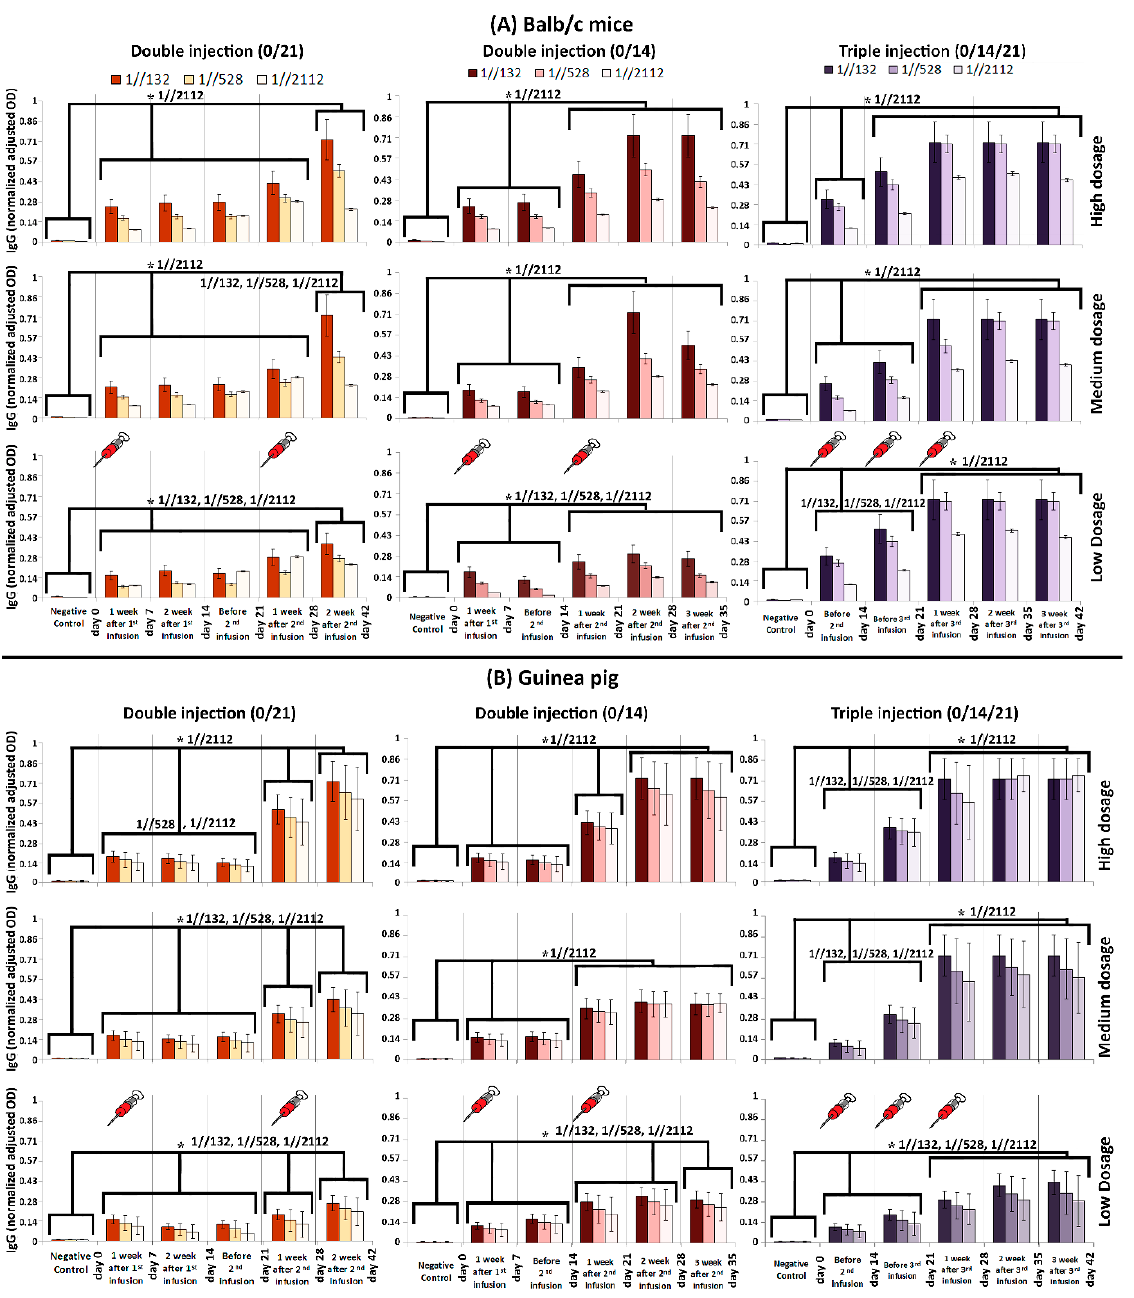
Figure 2. Humoral immunity in ( A ) Balb/c mice and ( B ) guinea pig monitored via IgG titration. Three dilutions (1//132, 1//528 and 1//2112) were prepared for each of the acquired sera samples. The humoral response was measured after double and triple infusions. The horizontal axis in each graph represents the time line of monitoring. The dosage of administrated vaccine candidate is depicted in the right of the figure. The comb-like bars above the columns of the graphs represent the groups of results that came out with significant differences in IgG titration (ELISA). The star above the comb represents which sera dilutions of comparing categories are different. For example, as what is shown in the top left panel, the IgG (OD) of “Negative control” is considerably less than the interval of “day 0–28”, while the IgG (OD) at “day 42” is considerably higher than both of “Negative control” and “day 0–28” interval, when the sera was diluted by 1//2112-fold. The vertical axis represents the normalized adjusted optical density (OD) of IgG at 450 nm. The obtained sera were diluted by 132, 528, and 2112 folds, and in cases that the recorded OD was more than one, the samples were diluted again, in a way that their absorbance gets ≤ 1. Then, the dilution rate (until the absorbance got ≤ 1) was multiplied by the OD to obtain an adjusted OD. In order to have a uniform and comparable range of adjusted ODs in all graphs, they were normalized in the range of 0–1. p -values of less than 0.05 were set as a cut-off for statistical significance.